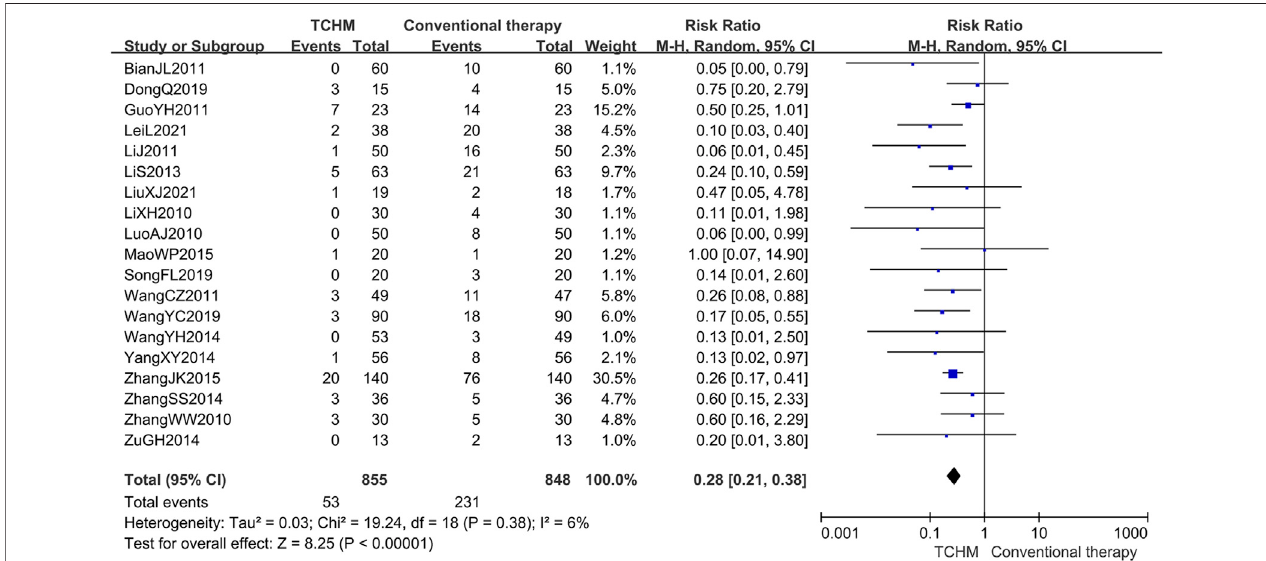
FIGURE 7 | Forest plot and pooled risk ratios for association of RTOG grading criteria with TCHM and conventional therapy.